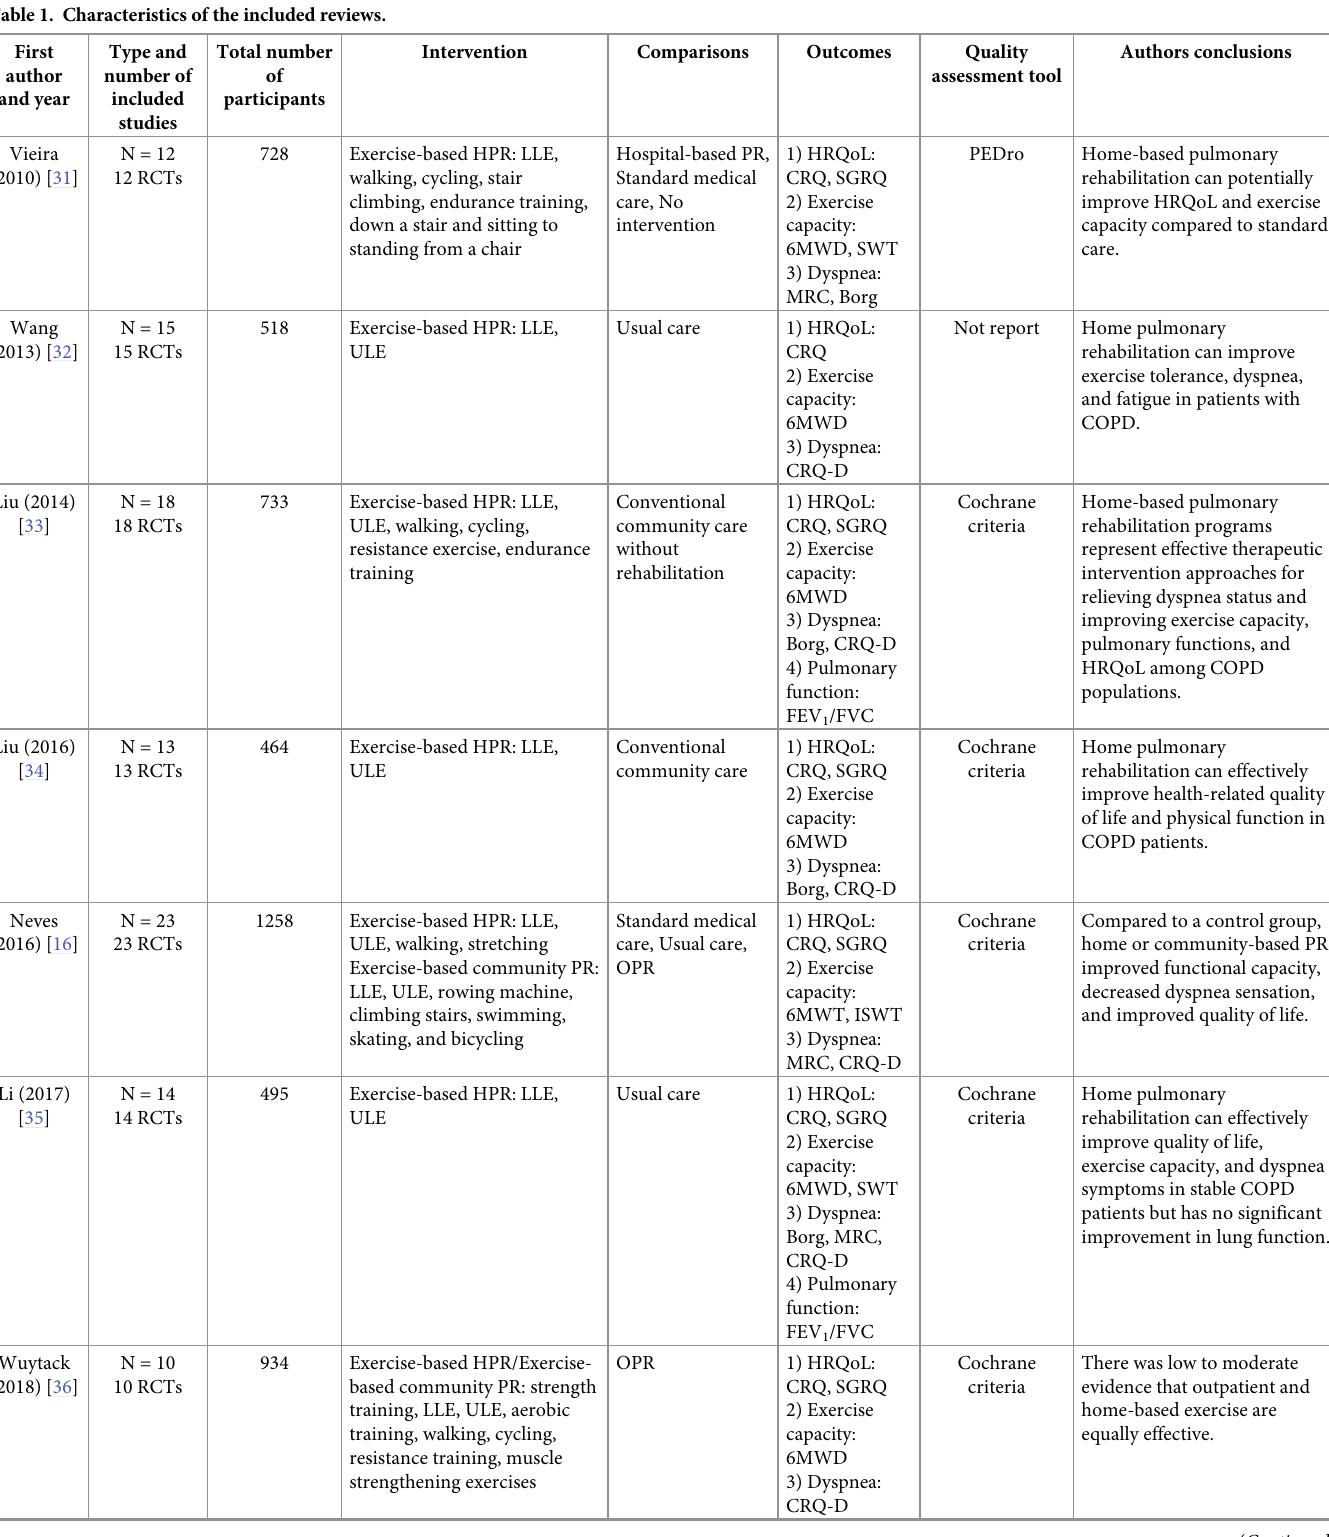
Table 1. Characteristics of the included